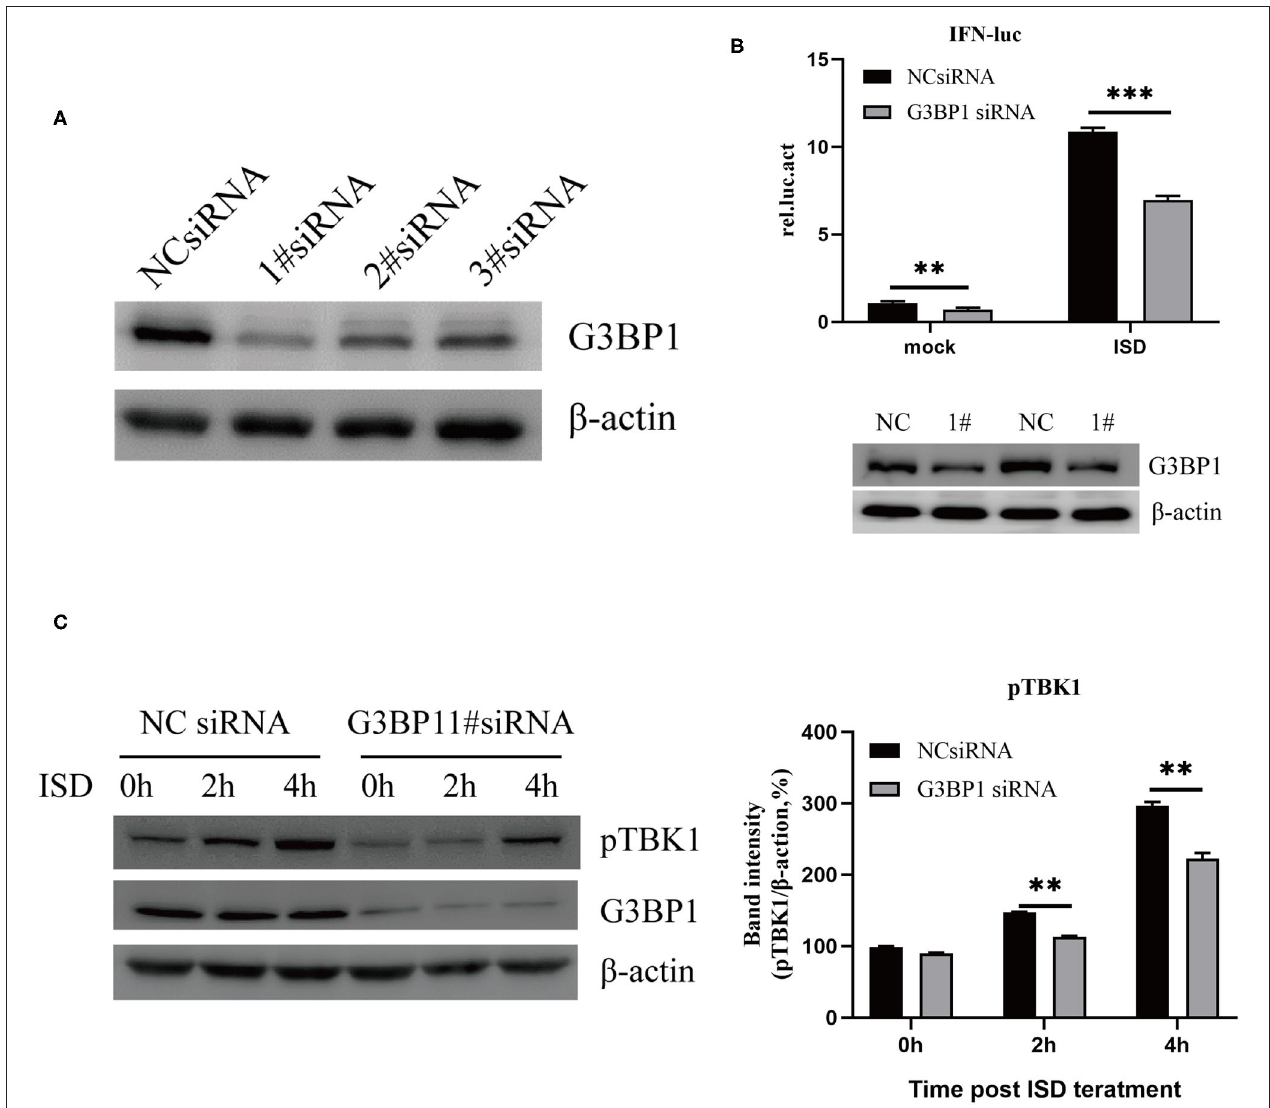
FIGURE 4 | G3BP1 is involved in DNA-induced IFN promoter activation. (A) Western blotting analysis of G3BP1 expression after siRNA transfection. (B) Depletion of G3BP1 inhibits DNA-induced IFN promoter activation. PK15 cells were transfected with the negative control (NC) or G3BP1 #1 siRNA and the indicated reporter plasmids 24h after siRNA transfection. The cells were then treated with ISD (2 µ g/ml) for 12h, and their luciferase activities were determined. G3BP1 and β -actin expression were detected by western blotting. (C) Depletion of G3BP1 inhibits DNA-induced TBK1 activation. PK15 cells transfected with NC or siRNA were treated with ISD, and 24h after siRNA transfection, the cell lysates were analyzed by western blotting and the intensities of the pTBK1 and β -actin bands were quantified and normalized to β -actin. The results represent data from three independent experiments, ** p < 0.01; *** p <